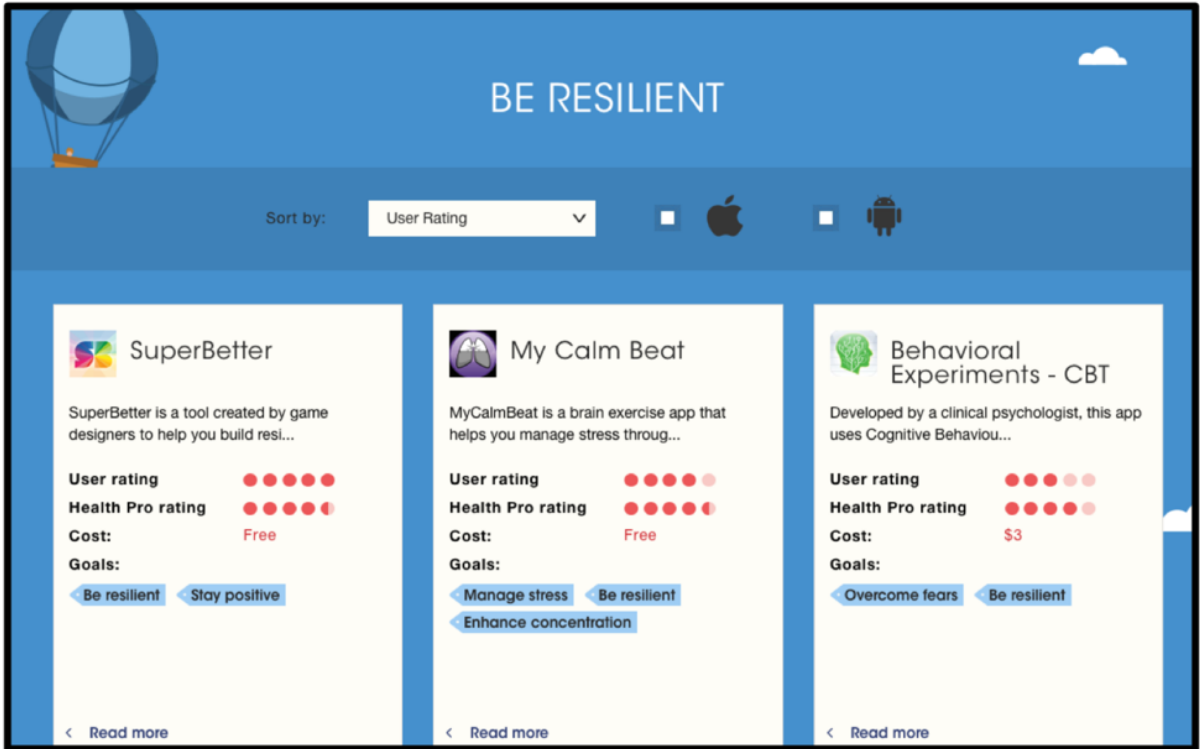
Figure 5. A screenshot from the health recommender system of Bidargaddi et al. Note the blue tags illustrating how each recommended app matches the